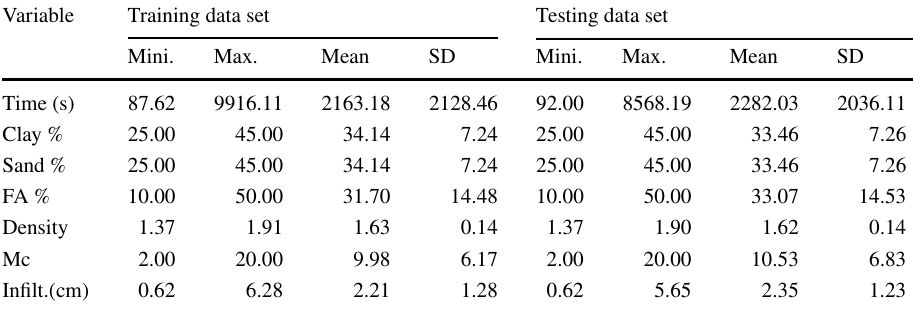
Variable Training data set Testing data